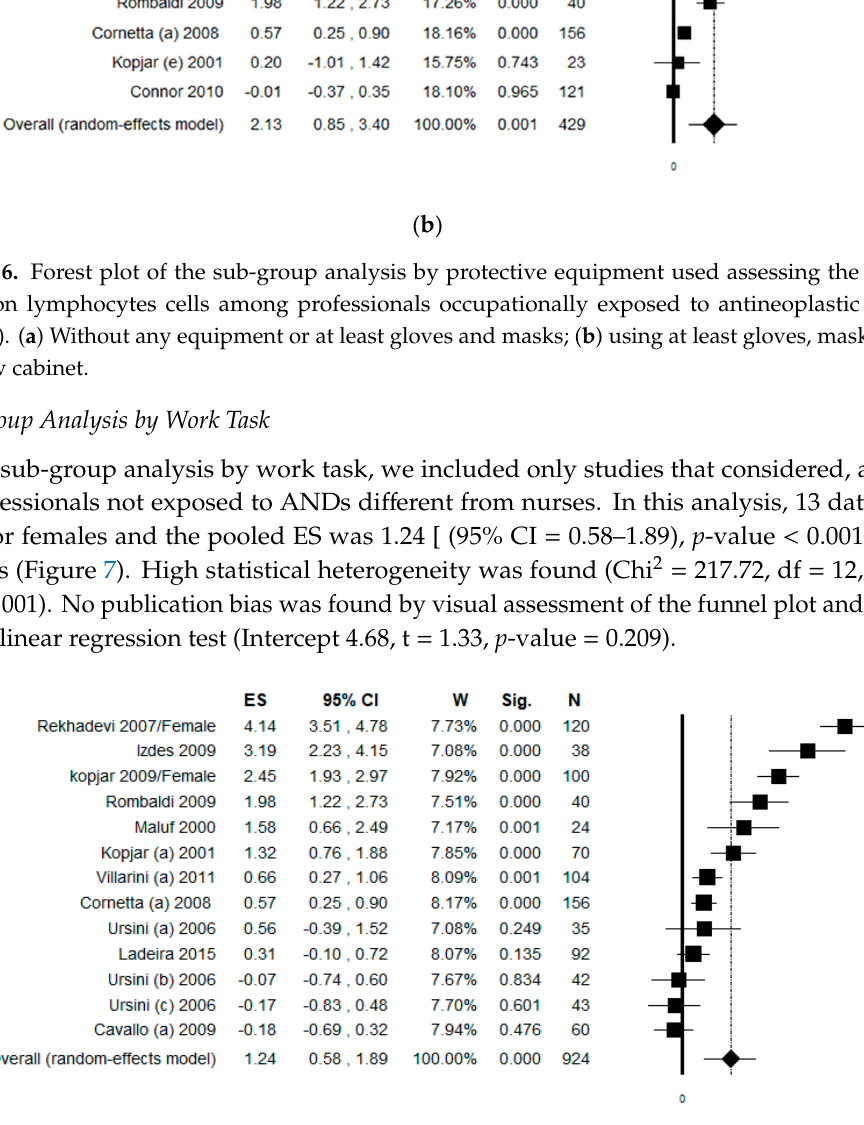
Figure 7. Forest plot of the sub-group analysis by work task (including only studies where controls were other health professionals different from nurses) assessing the comet assay on lymphocytes cells among professionals occupationally exposed to antineoplastic drugs (ANDs).